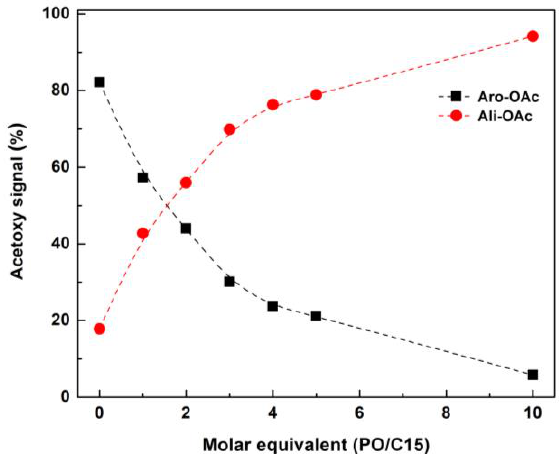
Figure 5. Relationship between acetoxy signal and molar equivalent of PO/C15. C15: number of carbon in catechin, basic unit of proanthocyanidins in P. radiata bark.